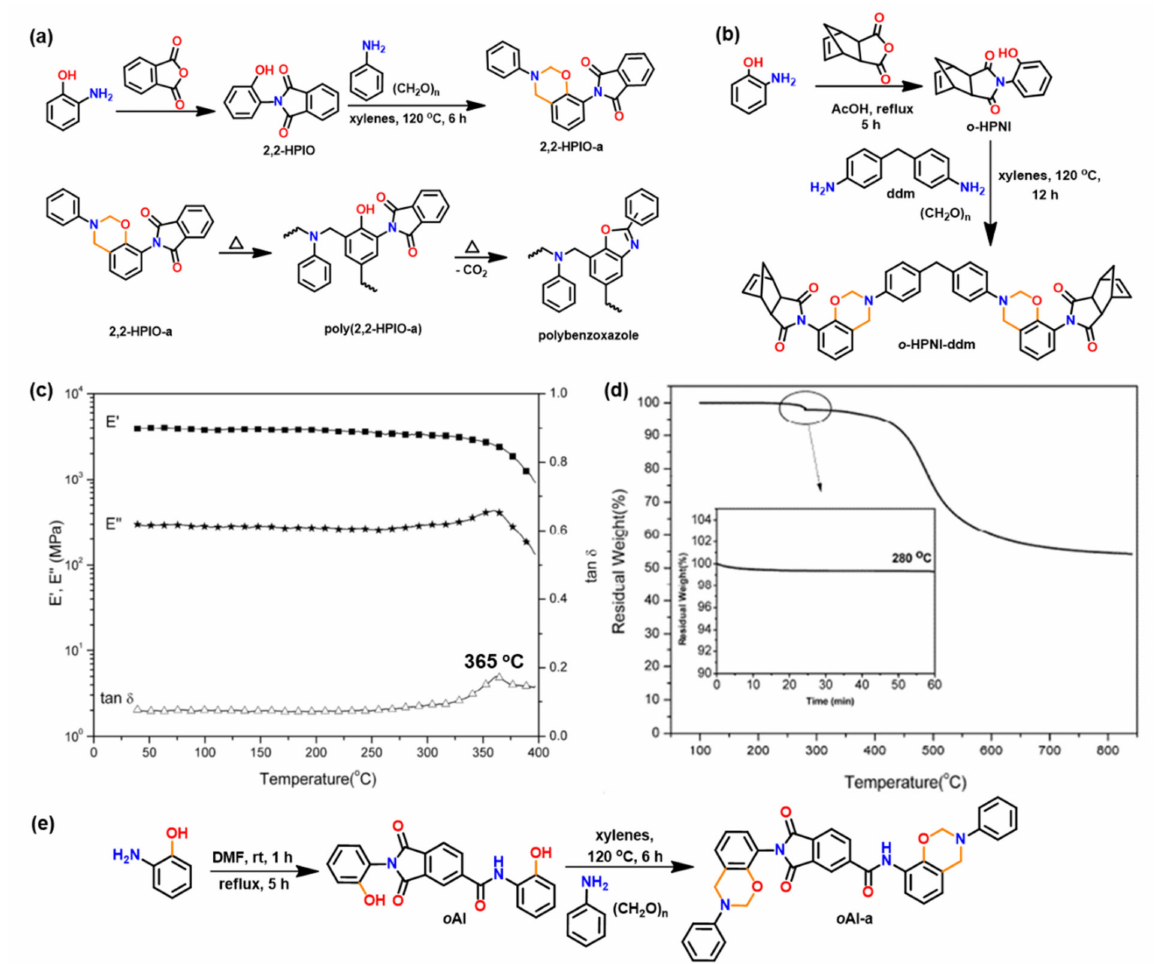
Figure 16. Synthesis of ( a ) o -imide [195], ( b ) o -norbornene functional imide Bz monomer [196] and ( c ) dynamic mechanical spectra of poly( o HPNI-ddm), upon further thermal treatment (280 ◦ C, 1 h) [196]. ( d ) TGA of poly( o HPNI-ddm). At 280 ◦ C, isothermal heating was applied for 1 h [196]. Copyright 2015. Reproduced with permission from Elsevier Ltd. ( e ) Synthesis of amide-co-imide functional benzoxazine monomer